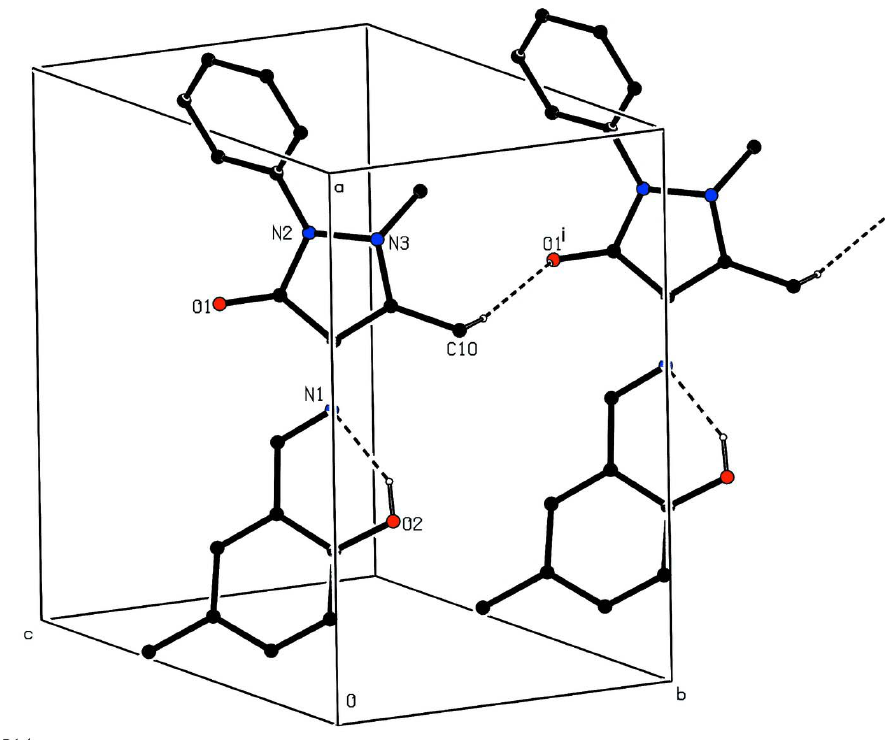
Figure 2 Partial packing view showing the formation of the chain through C-H···O hydrogen bondings displayed as dashed line. H atoms not involved in hydrogen bonds have been omitted for clarity. [Symmetry code: (i) x, 1+y,